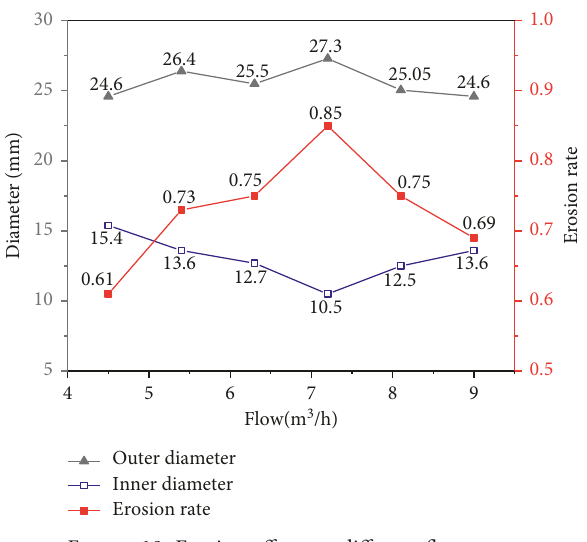
Figure 19: Erosion effects at different flow